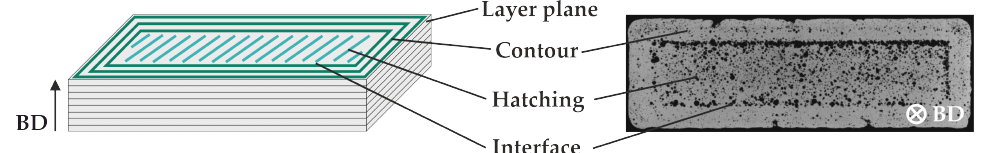
Figure 1. Schematicdrawing( left )andprojectionoftheminimumgrayvalueobtainedbymicro-computed tomography ( right ) of the three characteristic regions of different porosities in PBF-LB